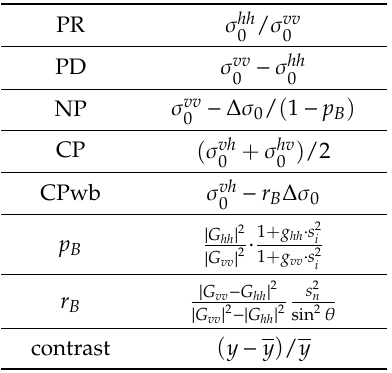
Table 1. Definition of the key